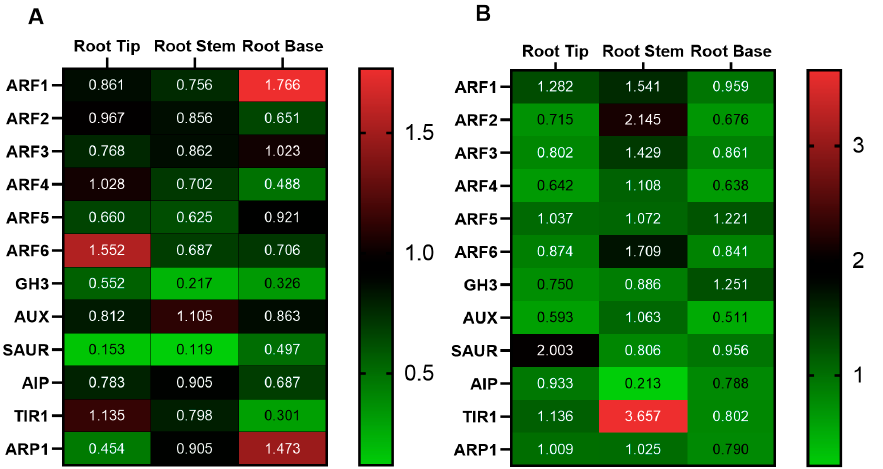
Figure 6. The expression profiles of 12 auxin response genes in tea roots after treatment with Al for ( A ) 6 h and ( B ) 7 d compared with the CK group.